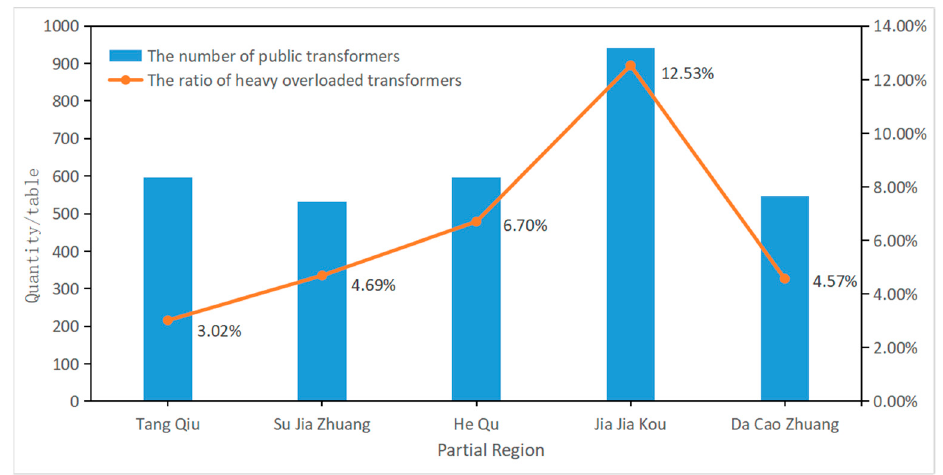
Figure 2. The ratio of the number of heavy overloads of public transformers in five typical power supply substations.